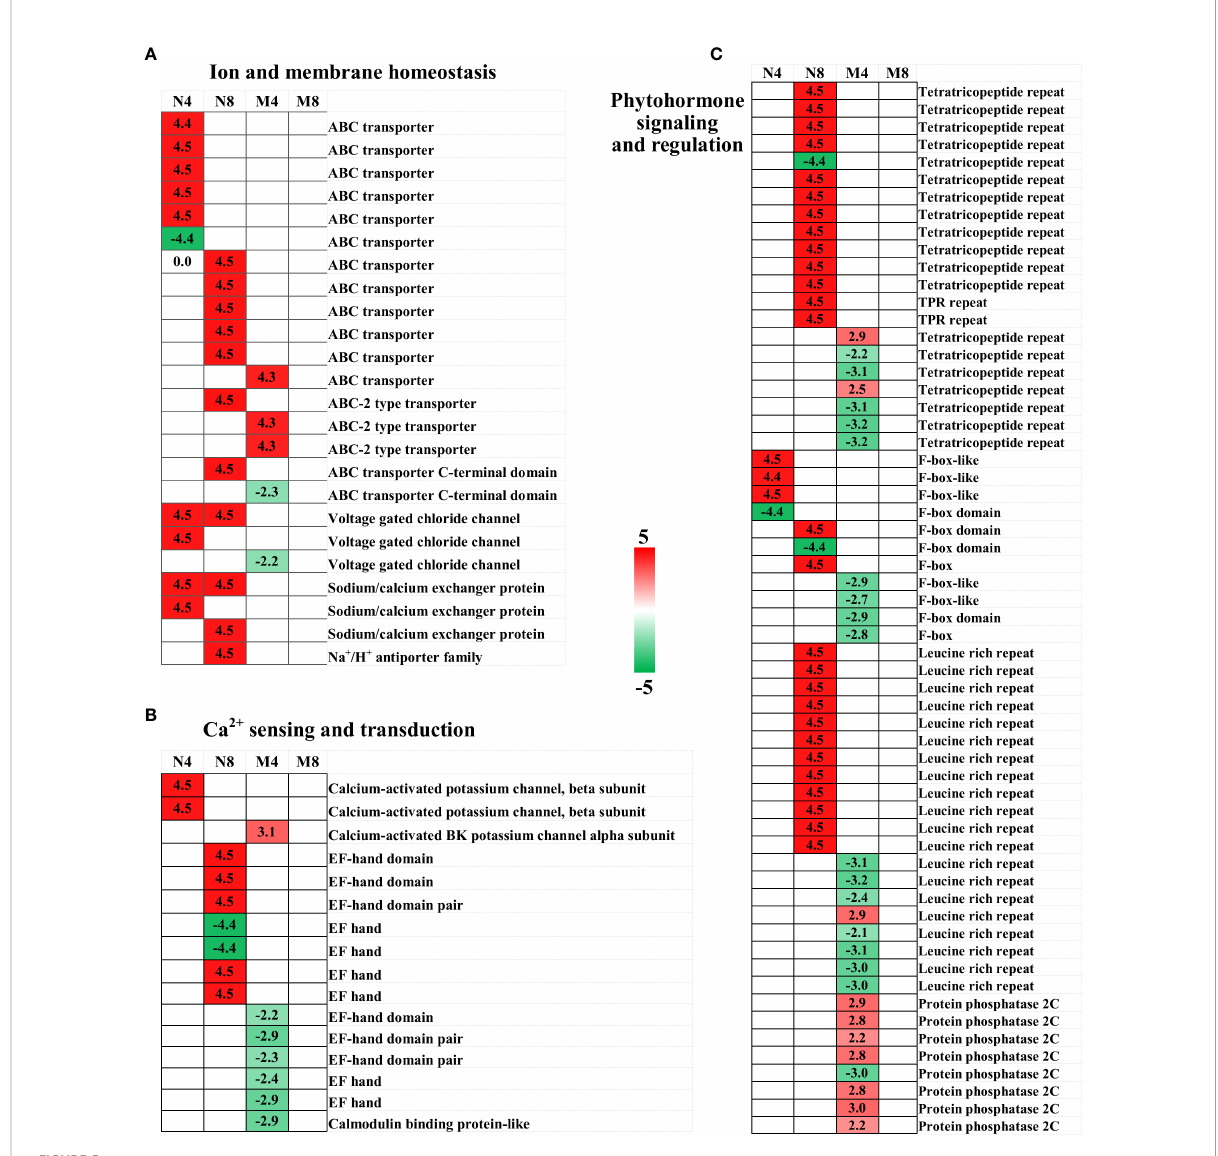
FIGURE 5 Heat map of candidate DEGs involved in ion and membrane homeostasis (A) , antioxidation process (B) , and phytohormone signaling and regulation (C) . The four columns, from left to right, represent N4, N8, M4, and M8. Color key is shown on the right. Red represents up- regulation, green down-regulation, and white no signi fi cant